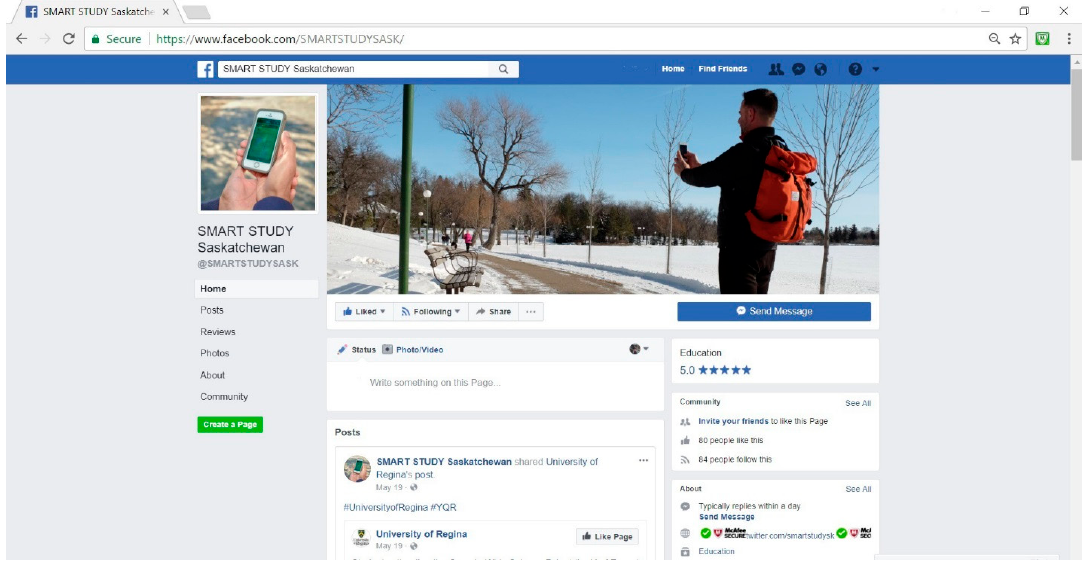
Figure 2. SMART Platform: Recruitment via social media.